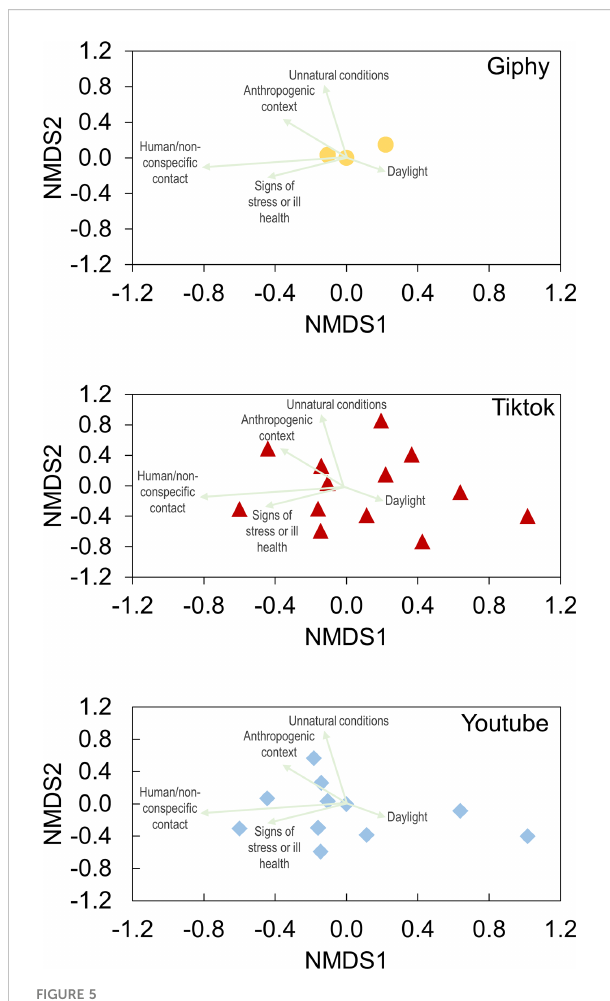
FIGURE 5 Non-Metric Dimensional Scaling representing the elements of the decontextualization score in videos from Giphy, TikTok and